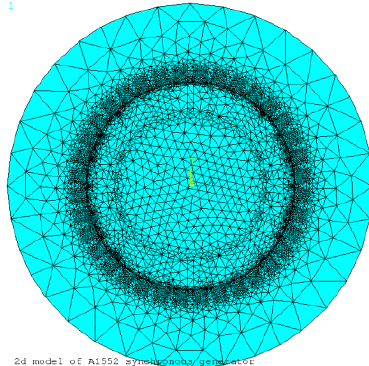
Figure 9. Finite element model meshed by triangle elements.